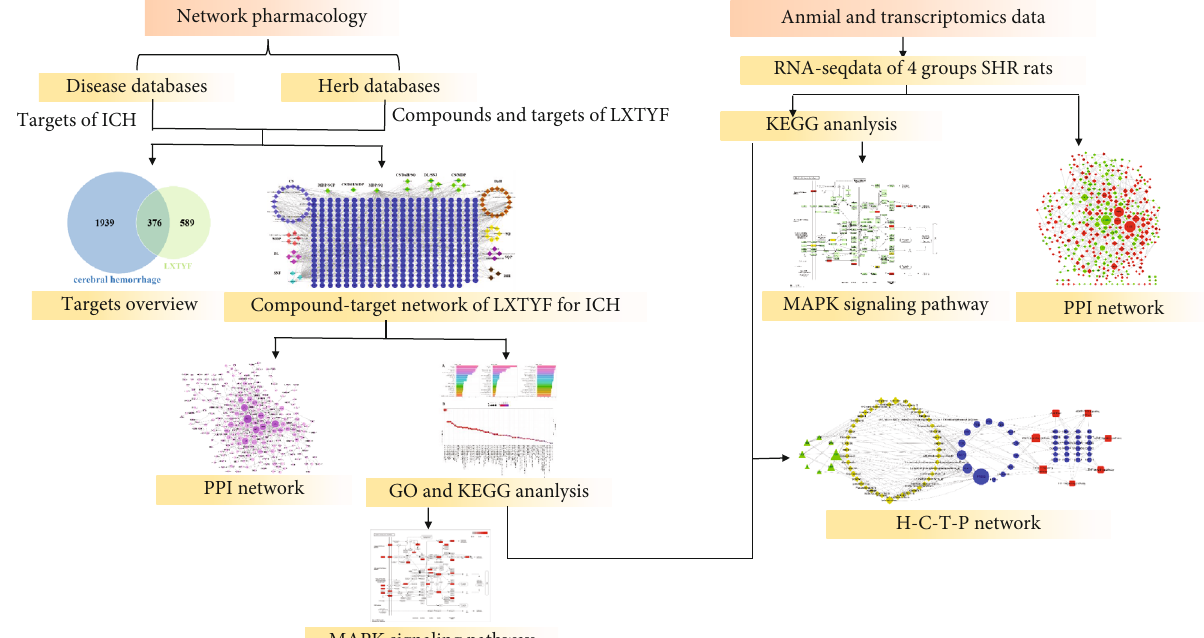
Figure 1: Outline of the study. Network pharmacology method and transcriptomics data were applied to explore the LXTYF e ff ect on (1) GAD (http://geneticassociationdb.nih.gov/), a public